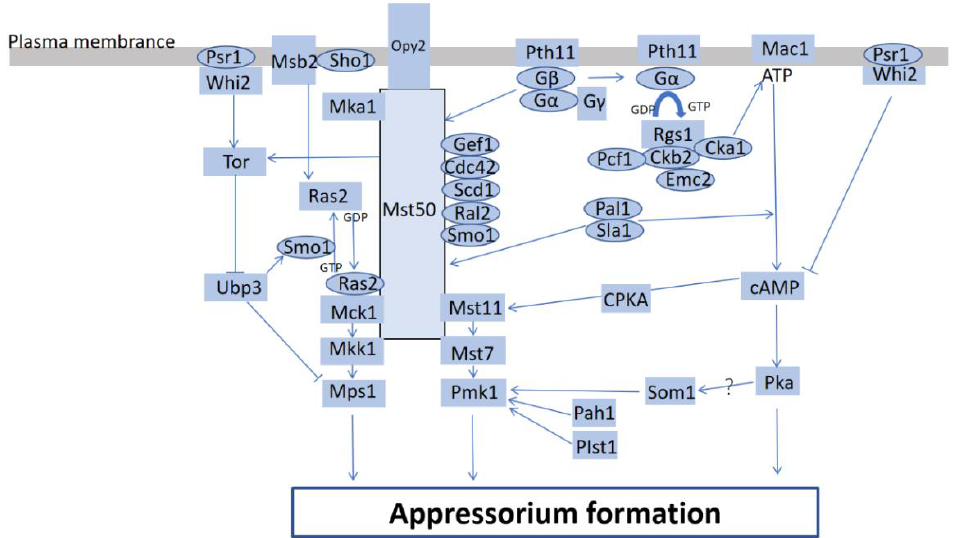
Figure 1. Several signaling pathways related to appressorium formation in Magnaporthe oryzae . The sensor proteins Msb2 and Sho1 activate the Pmk1 MAPK pathway; Whi2 interacts with Psr1, participating in the regulation of the cAMP levels and the Tor signaling pathway; Som1 functions downstream of the cAMP-PKA pathway, which may regulate the Pmk1 MAPK pathway through Som1. Rgs1 regulates G-protein signaling; the normal process of G-protein MoMagA-cAMP signaling depends on a condition of steadiness among Rgs1, Ckb2, and Emc2; Opy2 participates in the Mps1 MAPK pathway by interacting with Mst50; Ral2 interacts with Smo1, Scd1, and Mst50 to regulate the activation of the Mst11-Mst7-Pmk1 MAPK pathway by Ras2; Pmk1 pathway activation involves Mgb1, Ras2, and Cdc42; Mst50 activates Pmk1 through its interaction with Smo1, Cdc42, Scd1, Ral2; Pmk1 also requires the Mst7 and Mst11, which both bind to Mst50; Mka1, which interacts with Mst50, functions upstream of the MAPK pathway; Pal1 interacts with Sla1 and functions upstream of both cAMP and Pmk1–MAPK signaling pathways; Whi2 interacts with Psr1, participating the regulation of appressoria formation through the regulation of the cAMP levels and the target of rapamycin (Tor) signaling pathway; Ubp3 regulates GTPase-activating protein